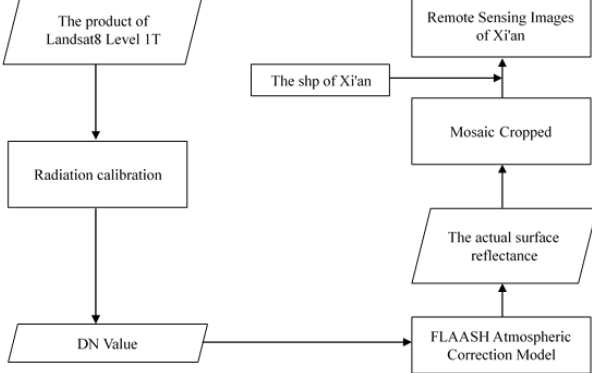
Figure 1. Landsat8 data pre-processing flow chart